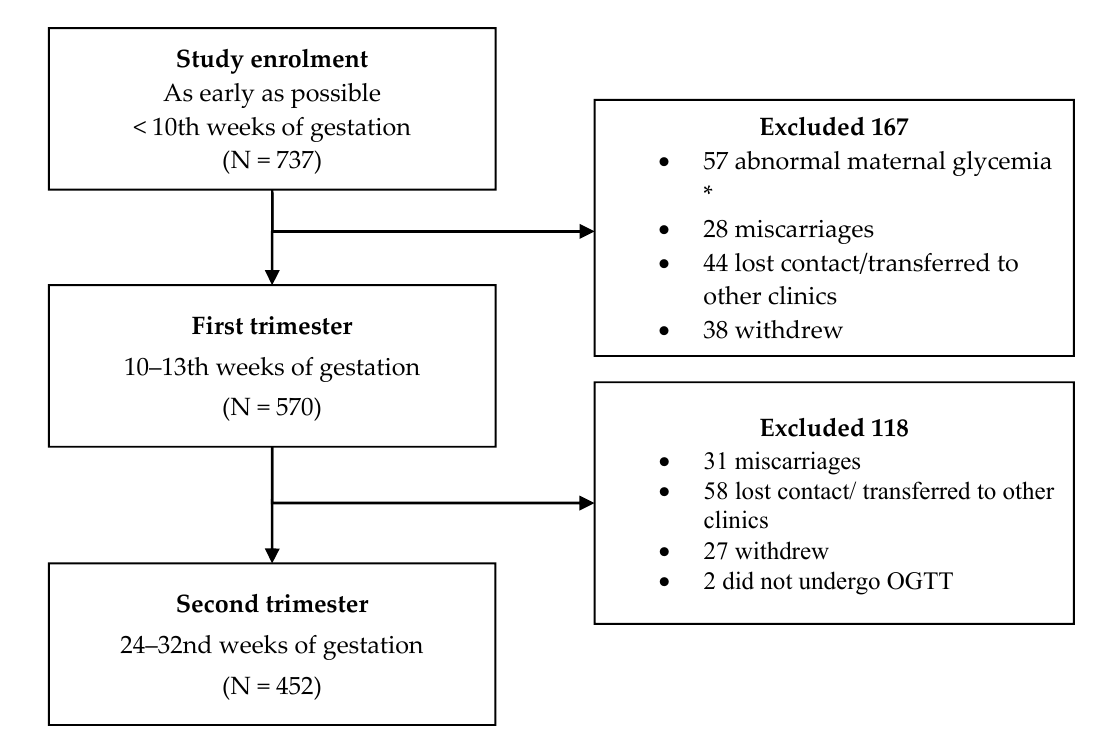
Figure 1. Recruitment of study respondents.